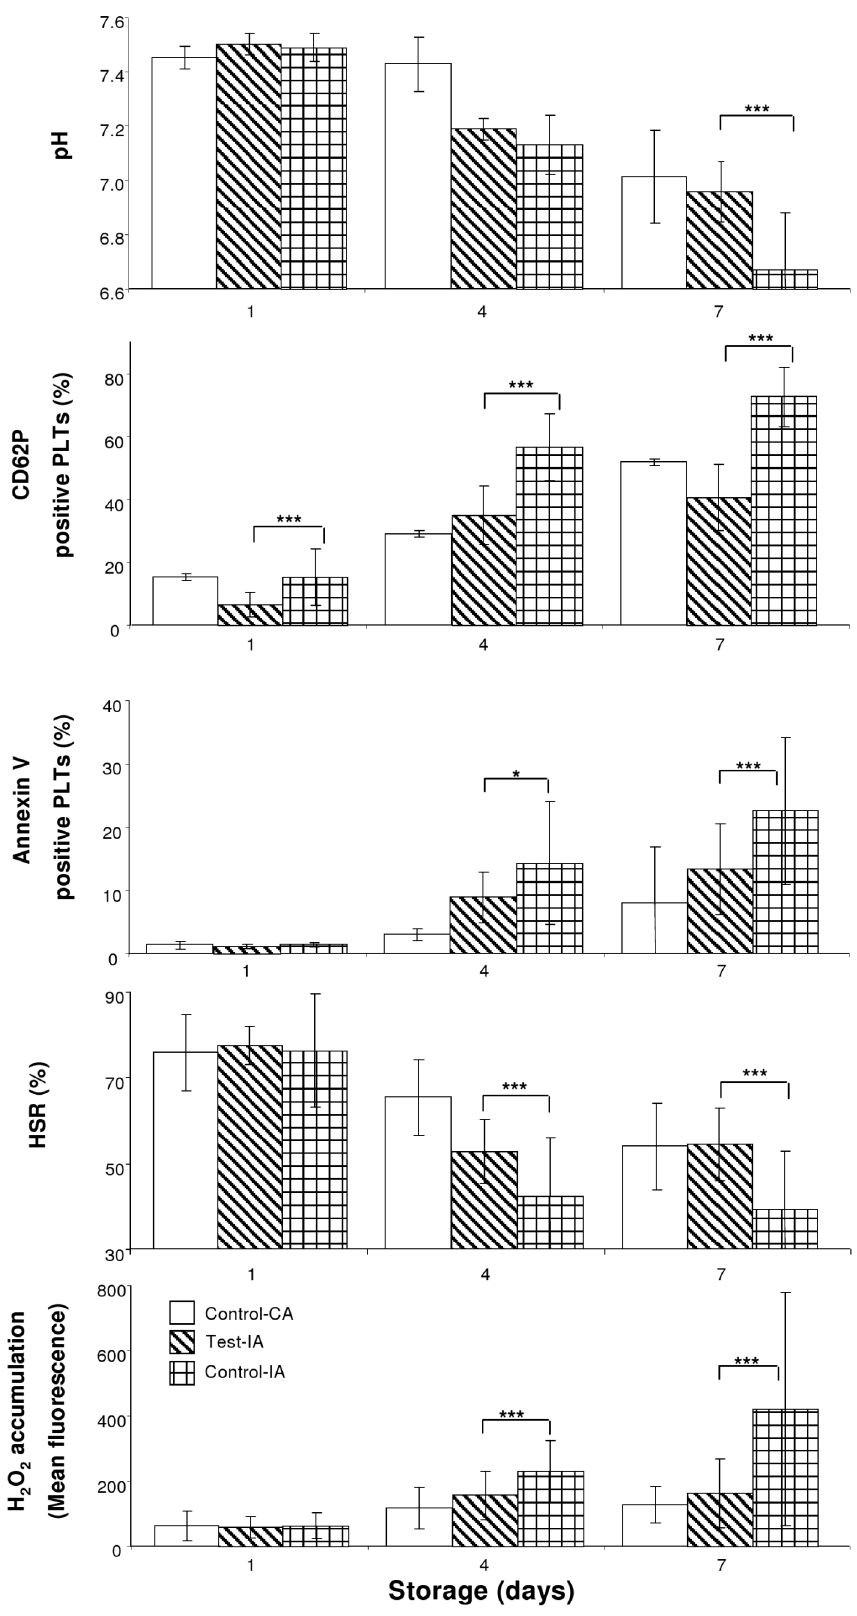
Figure 2. The pH levels, activation, Annexin V binding, HSR, and IHP accumulation of PLTs stored with 48 hours of interruption of agitation. * - p , 0.05; *** - p , 0.001. doi:10.1371/journal.pone.0070732.g002 PLOS ONE |